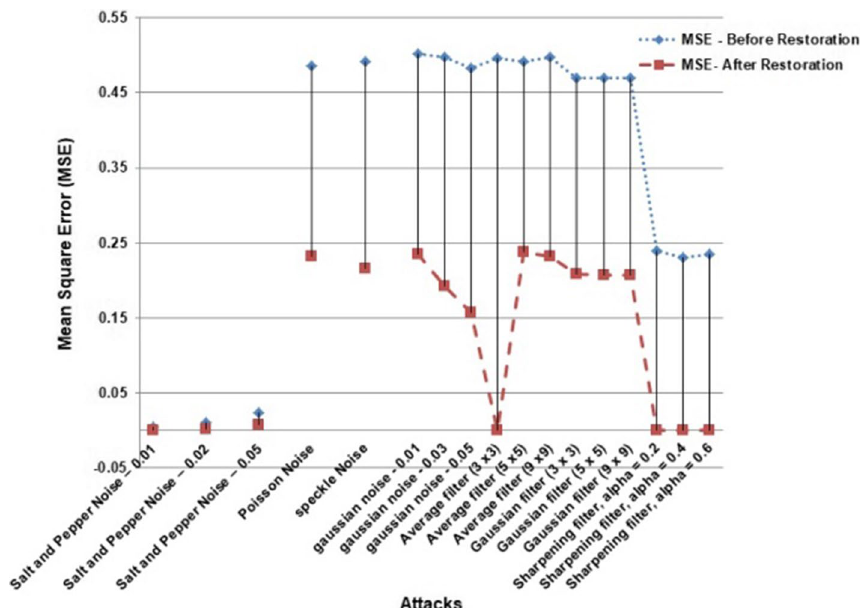
Fig. 12 Attacks vs. mean square